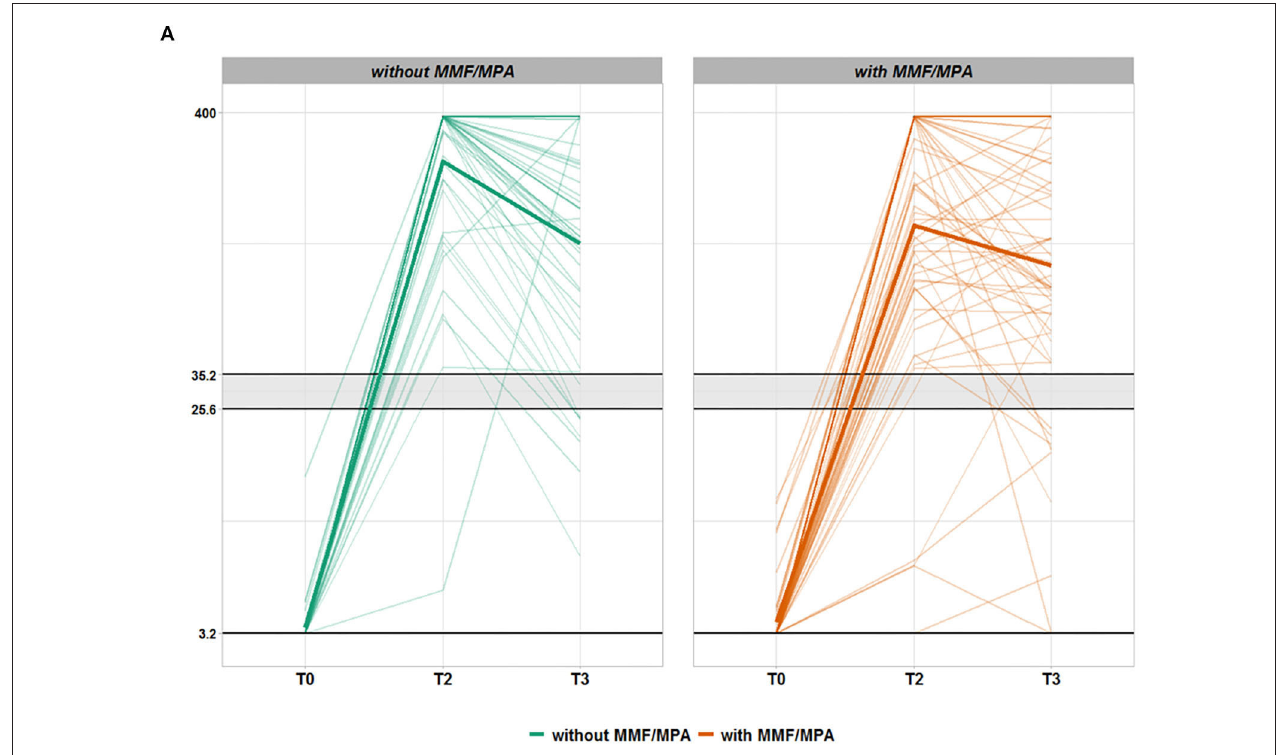
FIGURE 2A | Time course of anti-SARS-CoV-2 IgG antibodies in seroconverted kidney transplant recipients (KTR) without (green) or with (orange) mycophenolate mofetil or mycophenolic acid (MMF/MPA) treatment. Each thin line corresponds to the anti-spike S1 protein IgG antibody values (QuantiVac, Euroimmun) of a study participant from T0 (vaccination start) via T2 (8 weeks after vaccination start) to T3 (6 months after vaccination start). KTR being treated without MMF/MPA are represented in green and KTR exposed to MMF/MPA treatment are shown in orange. Only patients with successful de novo seroconversion at T2 (IgA or IgG antibody positivity against the SARS-CoV-2 S1 protein) after 2x mRNA vaccination and without SARS-CoV-2 nucleocapsid (NCP) antibodies were considered. The area shaded gray designates IgG borderline range below positivity level. The vertical axis is depicted on log 10 scale with the corresponding unit